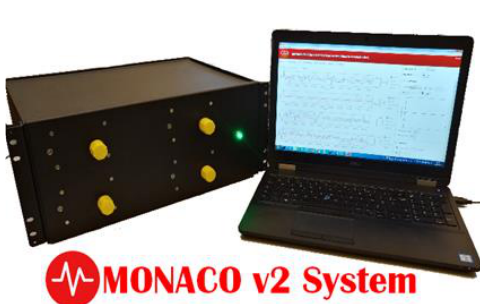
Fig. 2. CEA developed MONACOv2 acquisition system for fission chambers.